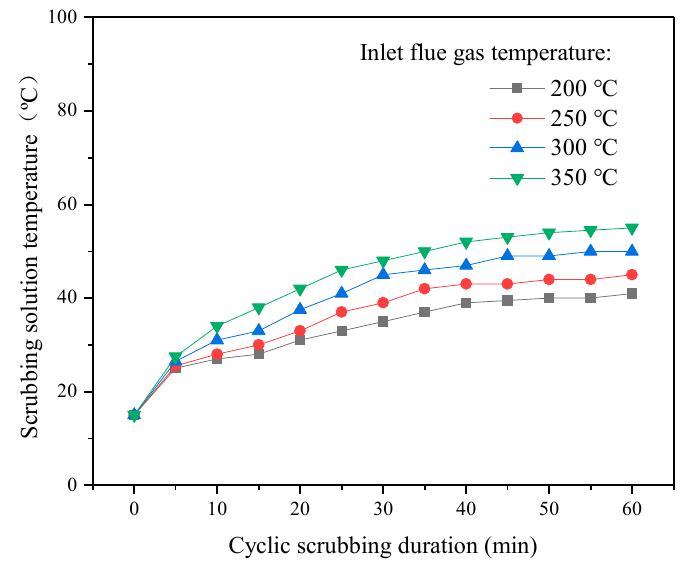
Figure 3. Effect of seawater scrubbing temperature (Initial temperatures of the scrubbing solution were 23 ◦ C. Washing liquid flow rate was about 1 L · min − 1